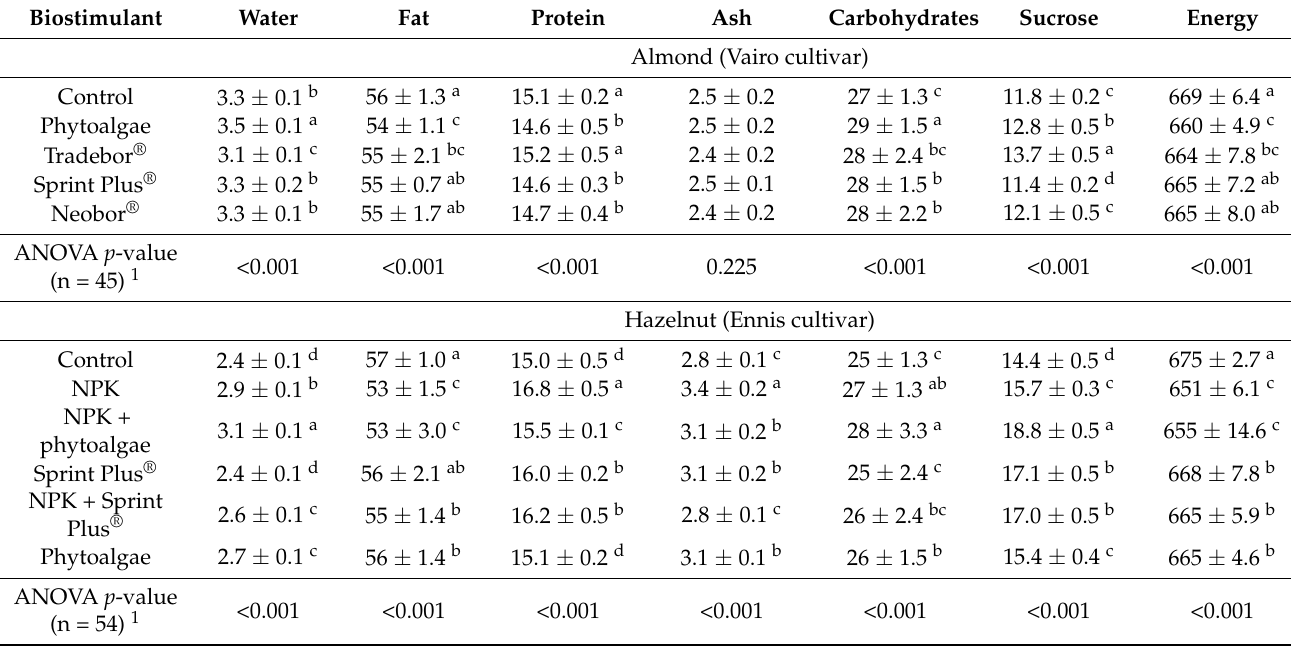
Table 1. Nutritional composition (g/100 g fw) and energy values (kcal/100g fw) for almond and hazelnut cultivars submitted to different plant biostimulants